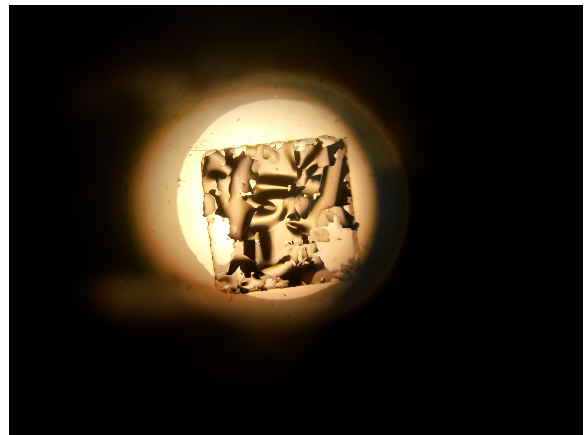
Figure 11. Delaminating layer on the second detector